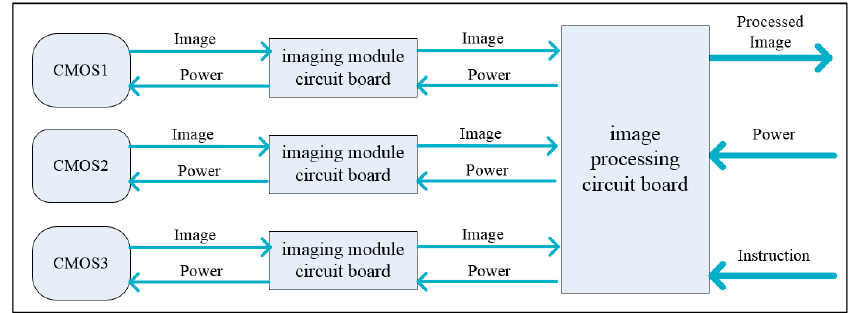
Figure 5. Schematic diagram of electronic system.